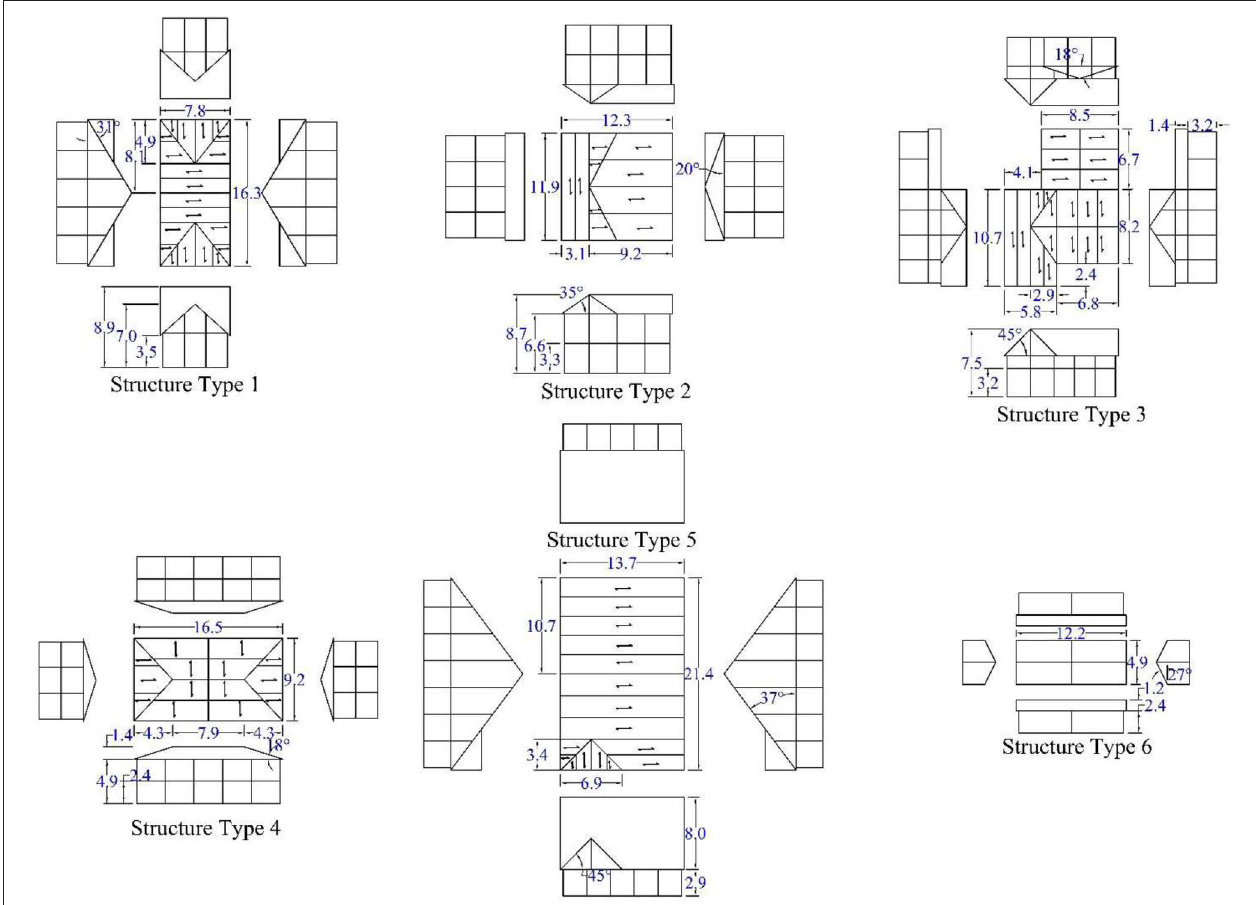
FIGURE 1 | Archetypes used in study of CLT residential structures (dimensions in m).